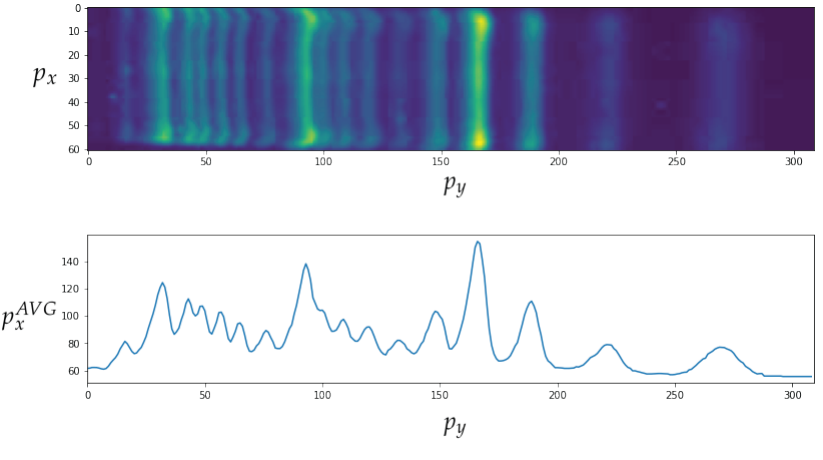
Figure 17. The top image shows the automatic clipping of the ladder band. The bottom image shows the average curve, where p y is the vertical position and p AVG x is the average horizontal value p x .